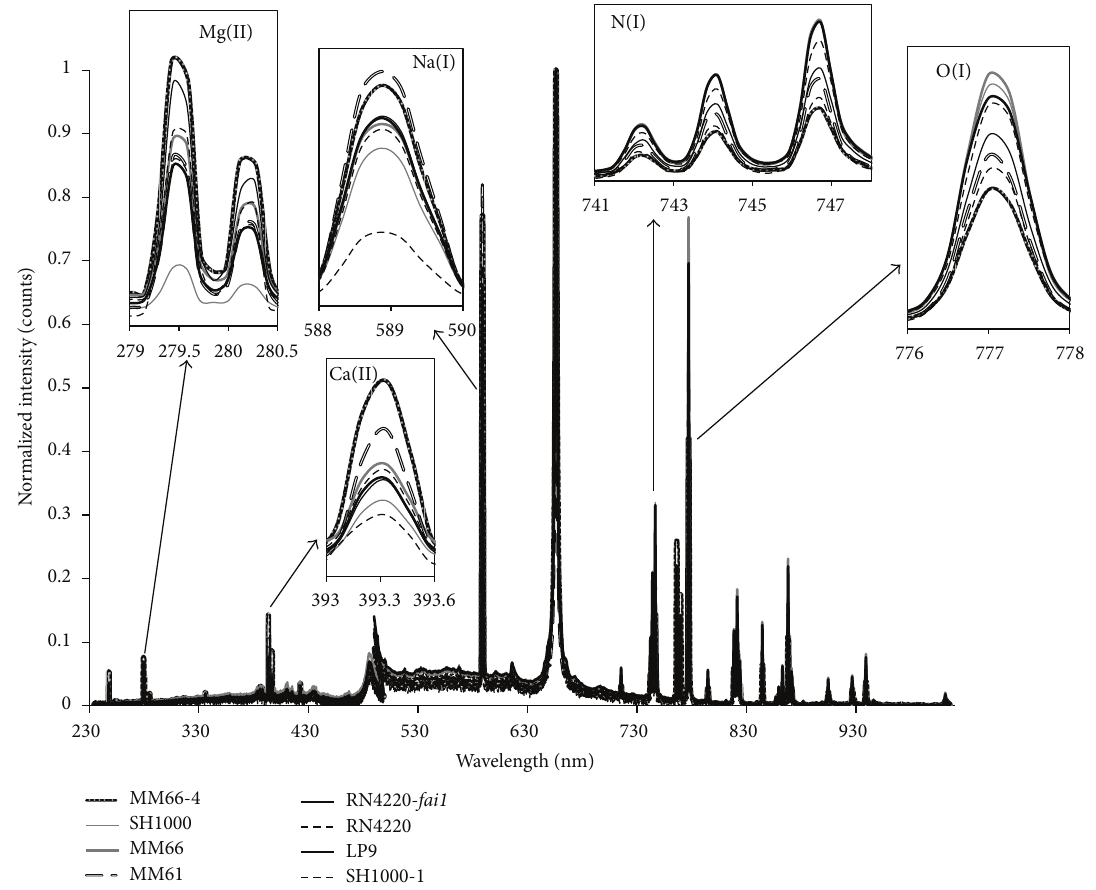
Figure 3: Examples of LIBS classification spectra used for building strain